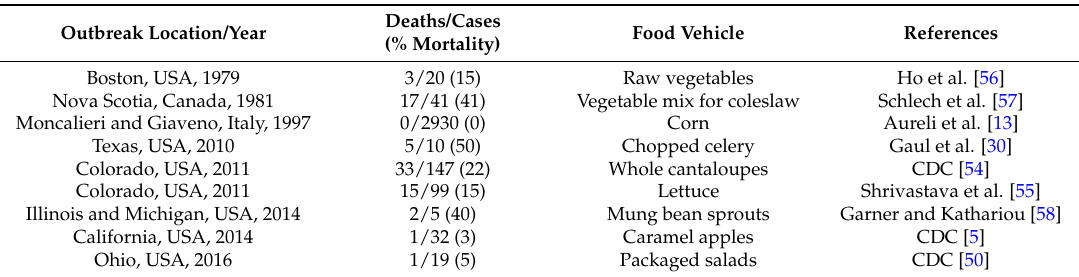
Table 1. Listeriosis outbreaks associated with fresh produce.